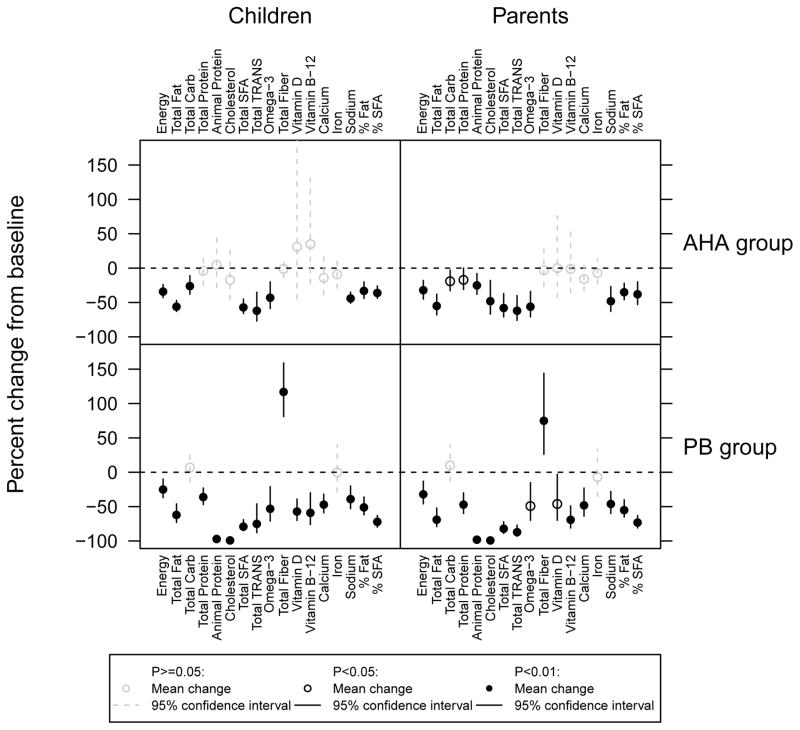
Nutrient Outcomes Within GroupsSFA-Saturated Fatty Acids, Trans-Trans Fats